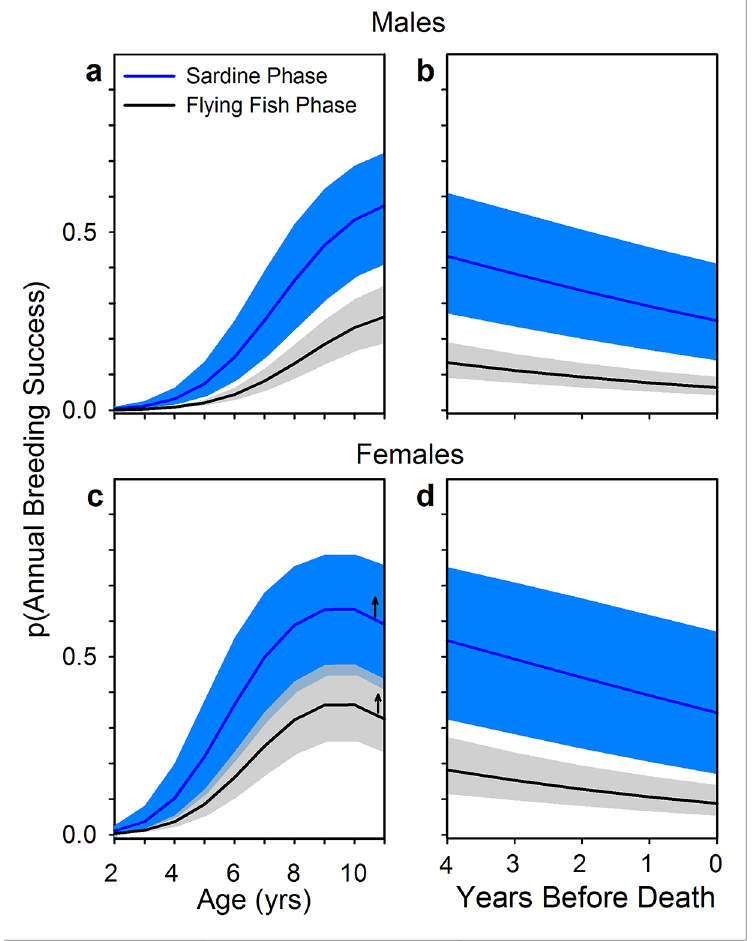
Fig 3. Annual Breeding Success by Fish Phase. Annual BreedingSuccess is the probabilityof producing an independent offspring if alive in that year. Results shown for young and middle-aged males (a) and females (c), and for presumedold males (b) and females (d). Curves ( ± 95% CI) are predictionsfrom generalized linear mixed models with a binomial error structure, controlling annualSSTA variability. Data come from all 19 years of the study, including years without other breedingdetails(negativeslope for females aged10–11 is an artifact of fitting a quadratic function to an age series that becomes level at age 8–9 yrs [see S5 Fig], as indicatedby arrows). Full model results given in S1–S4,S7 and S8